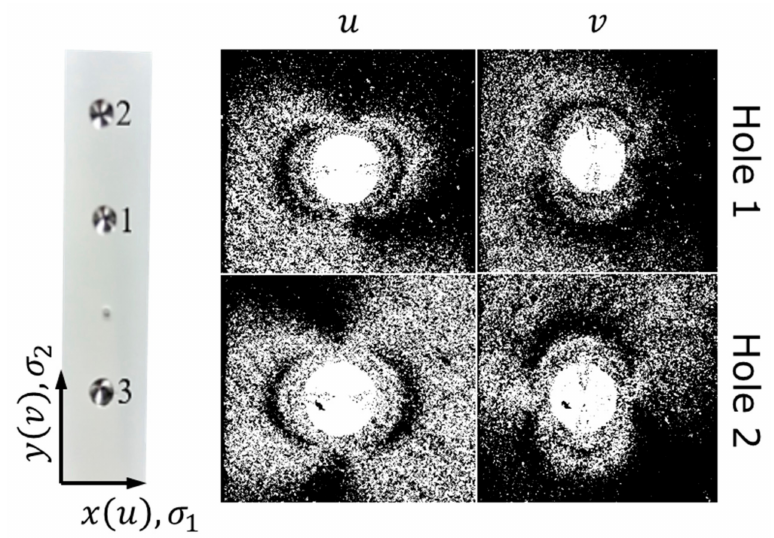
Figure 4. Appearance of drilled holes and interferograms for holes 1 and 2 with the corresponding